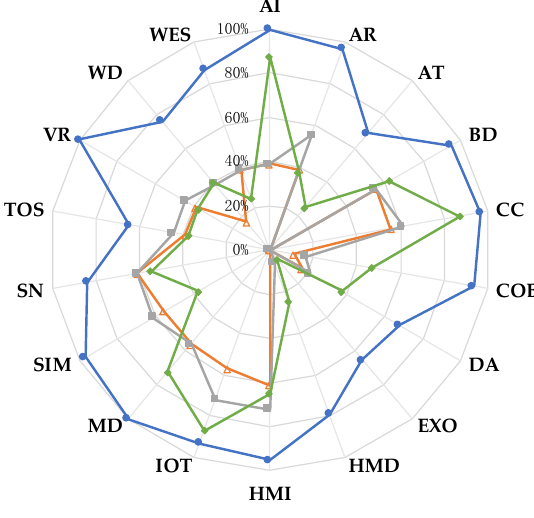
Figure 3. Prior knowledge and use of the Operator 4.0 enabling technologies. 294